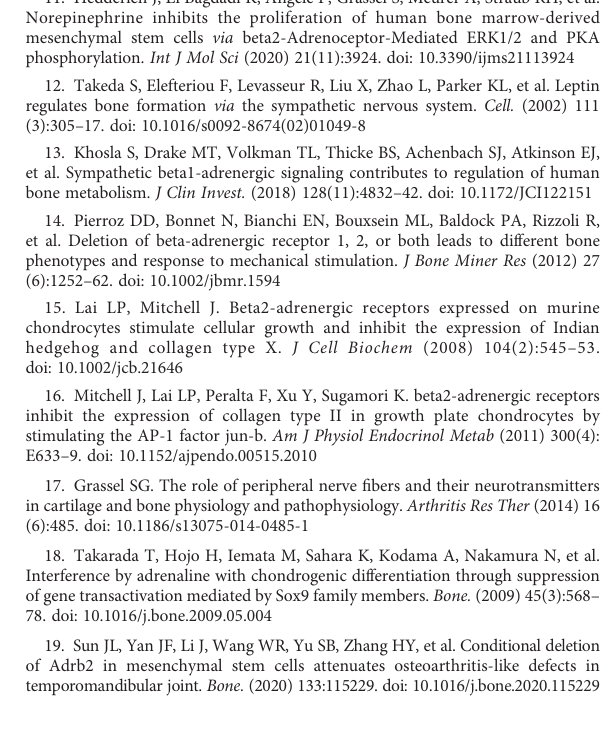
SUPPLEMENTARY FIGURE 2 Bone turnover markers in TH CD11b-Cre mice. (A) PINP and (B) CTX-I serum concentrations in 12-week-old TH fl ox/ fl ox and TH CD11b-Cre mice